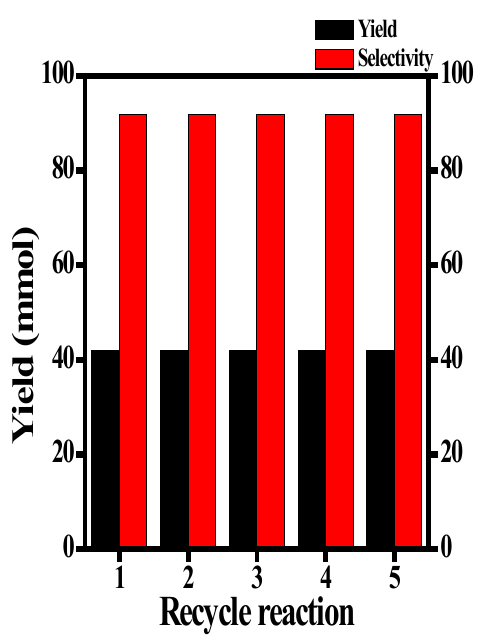
Figure 10: Reusability of EG[Vim] of DMC production under reaction conditions: MeOH: 625 mmol, IL: